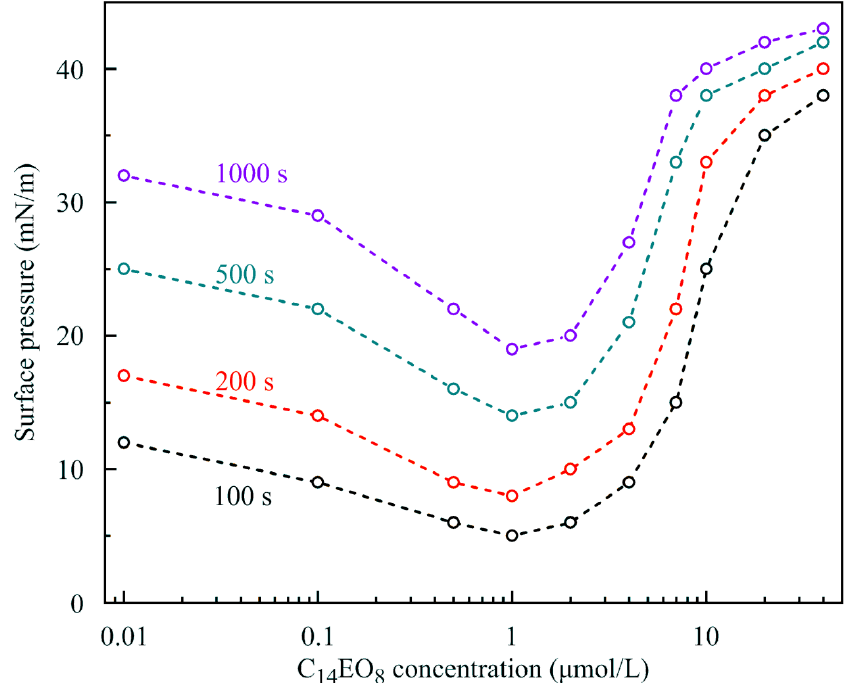
Figure 11. Dependencies of dynamic surface pressure on C 14 EO 8 concentration at times shown in the figure for solution drops of volume 24 mm 3 formed on capillary 3 mm in diameter. Dashed lines are guides for the eye. Colloids Interfaces 2020 , 4 , x FOR PEER REVIEW